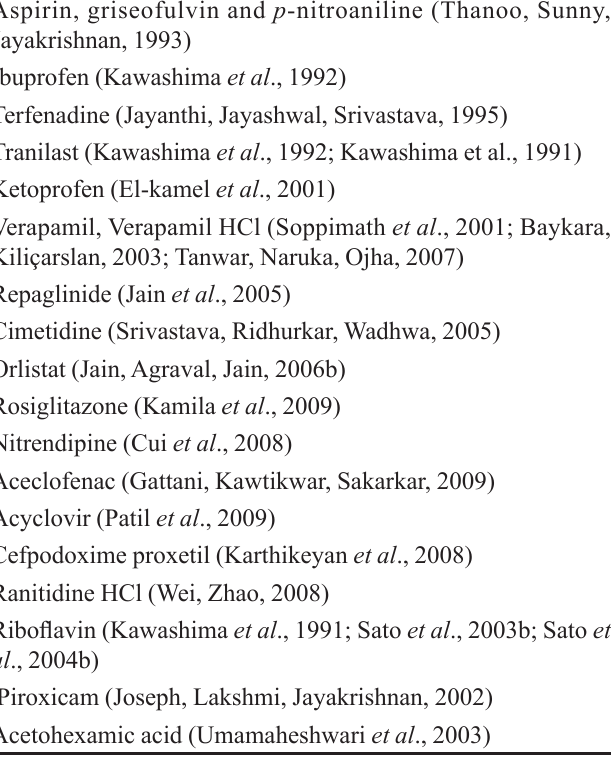
TABLE I - List of the drugs formulated as a floating